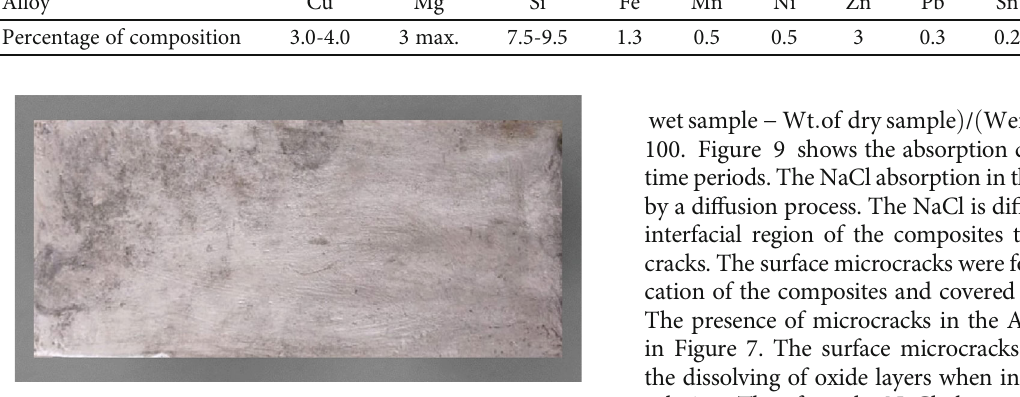
Figure 1: Casting sample of Al/GO